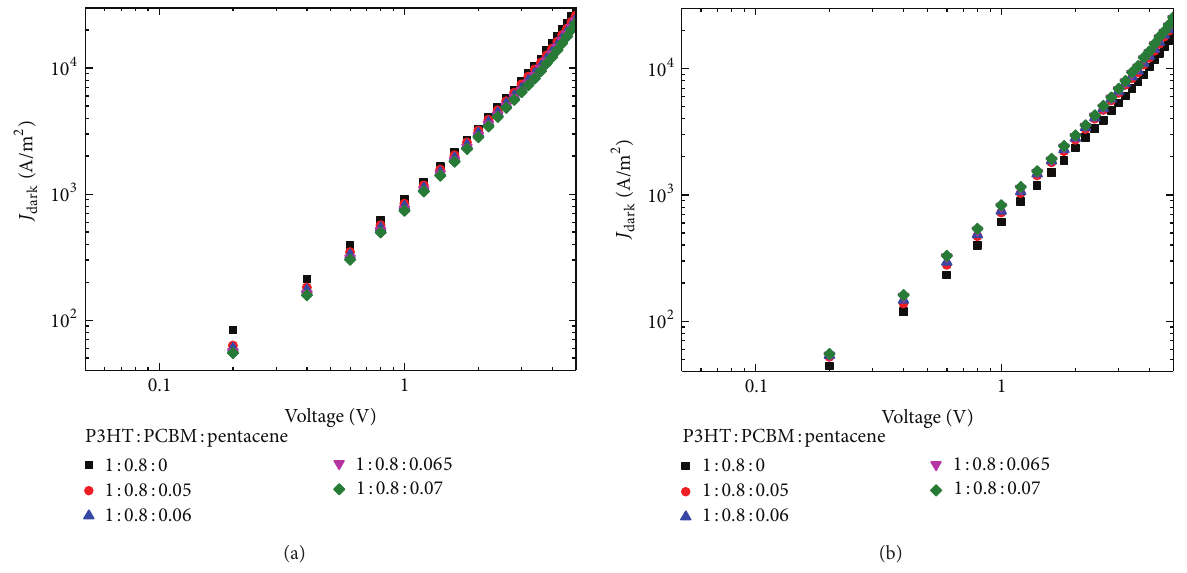
Figure 2: The dark current densities for (a) electron-only devices and (b) hole-only devices with the absorption layer of various pentacene doping contents.